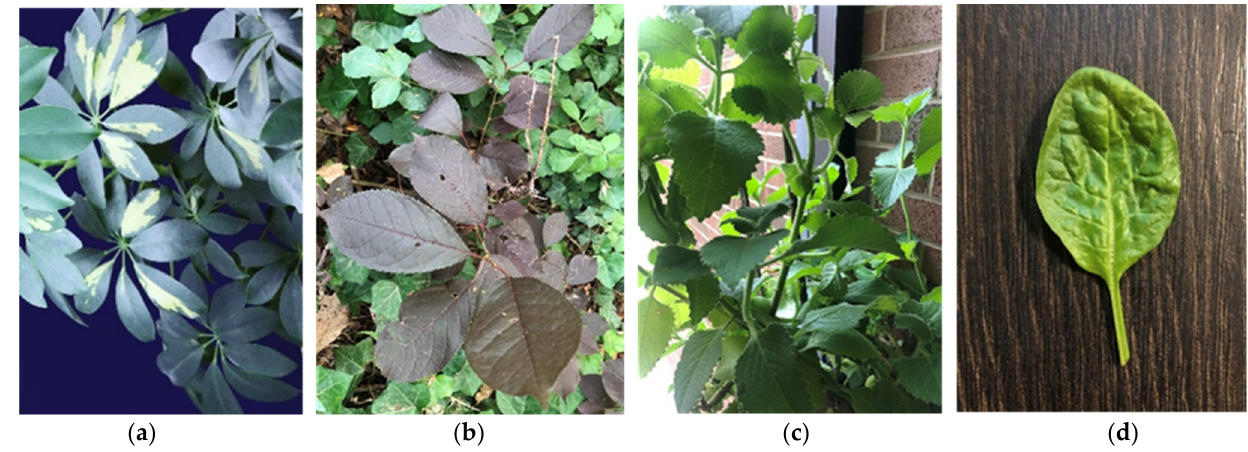
Figure 1. From left to right, the plants tested are ( a ) Schefflera arboricola , ( b ) Prunus virginiana , ( c ) Coleus amboinicus , and ( d ) Spinacia oleracea.